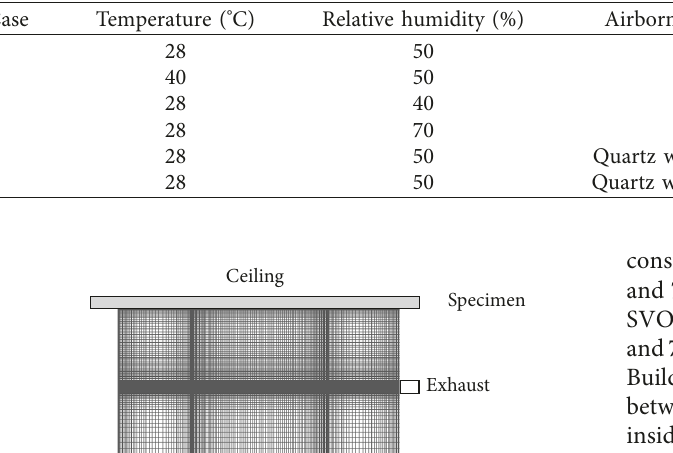
Table 3: A list of test cases (air exchange rate